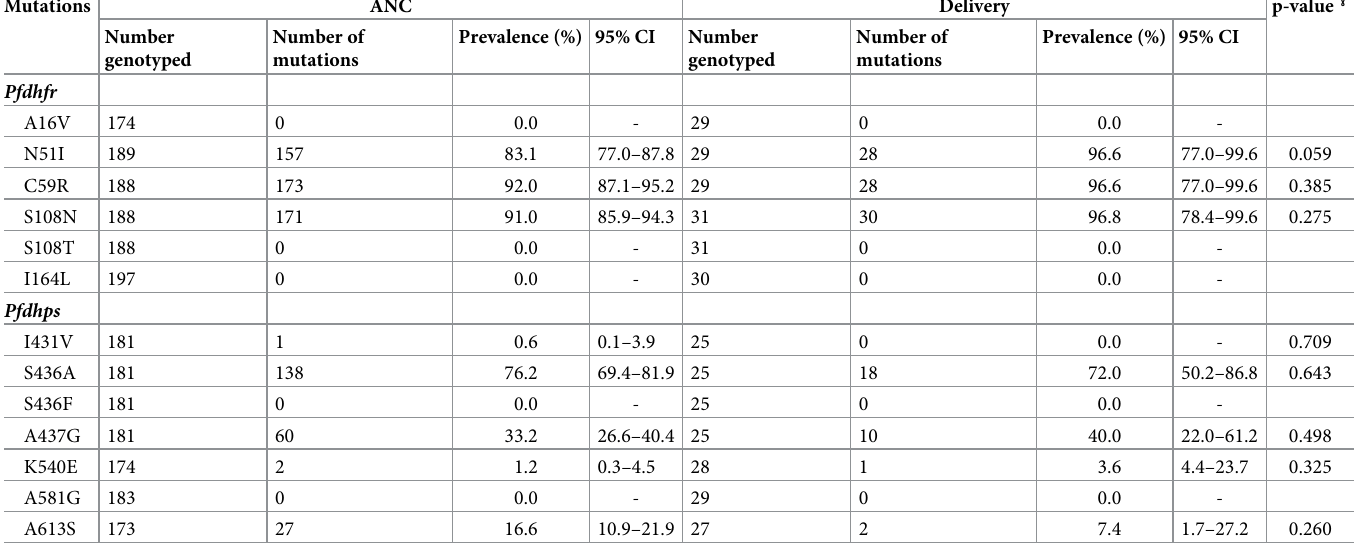
Table 2. Prevalence of amino acid mutations translated from nucleotide sequence in the P . falciparum Pfdhfr and Pfdhps genes at first ANC clinic visit and at deliv- ery in the forest-savannah area of Ghana.